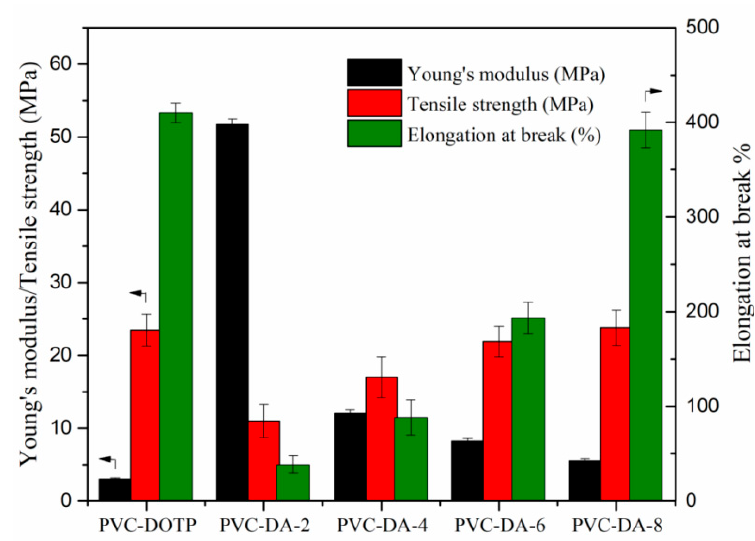
Figure 7. Tensile properties of PVC-DA-2n (2n = 2, 4, 6, 8) and PVC-DOTP.